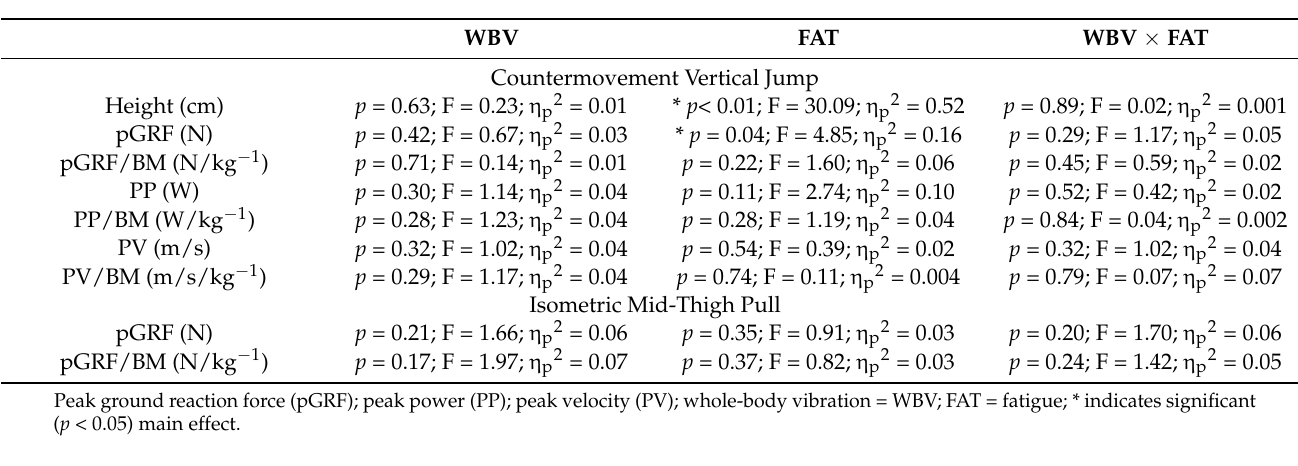
Table 2. Vertical jump and isometric mid-thigh pull main effects and interaction results (n = 28).